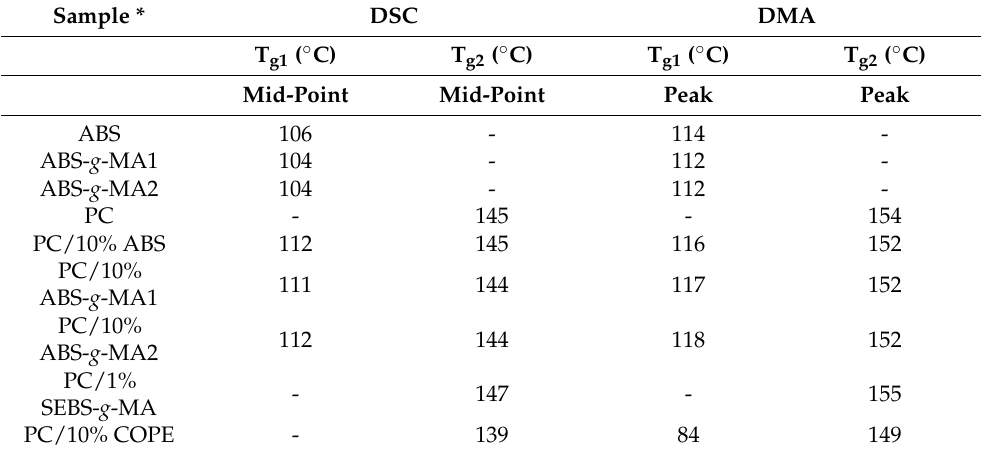
Figure 5. SEM micrographs of cryogenic fractured tensile specimens: ( a – c ) PC/SEBS- g -MA and ( d ) PC/COPE blends. Table 3. Thermal properties of initial polymers and blends, using DSC and